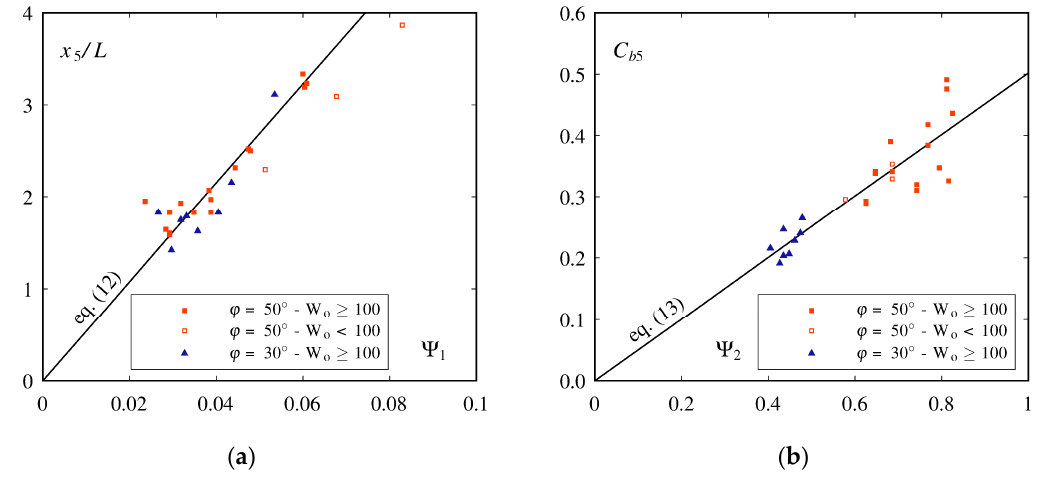
Figure 11. Bottom maximum characteristics: ( a ) relative streamwise position x 5 / L as a function of Ψ 1 = (1 + sin φ ) − 2 ·(1 + tan α ) − 4 ·F o − 1 ·( t / h o ) − 0.3 ·(s/ h o ) 0.3 , and ( b ) bottom air concentration C b 5 as a function of Ψ 2 = sin 1.5 φ ·F o0.2 ·( t / h o ) 0.25 (s/ h o ) − 0.1 .